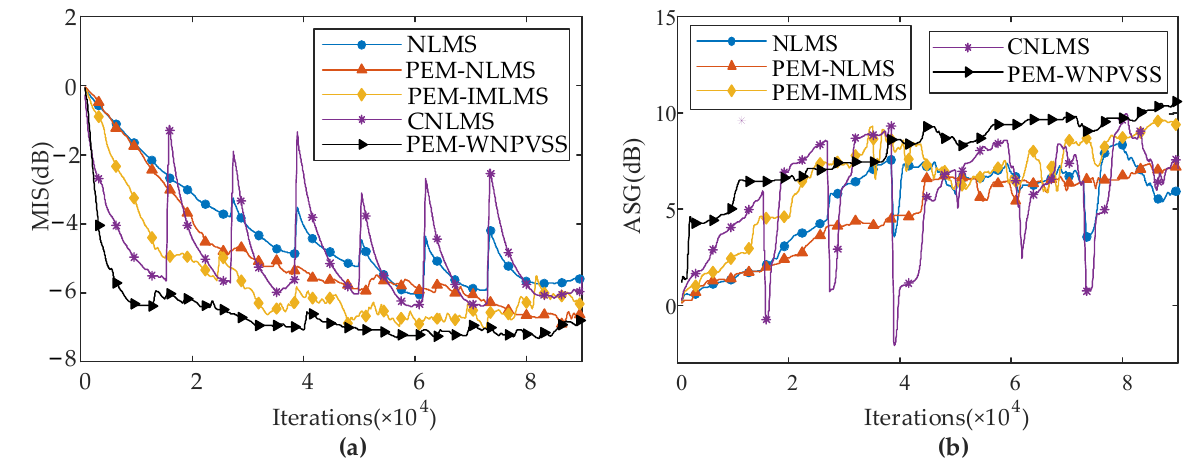
Figure 7. Performance of five algorithms with an impulse noise input: ( a ) MIS; ( b ) ASG.